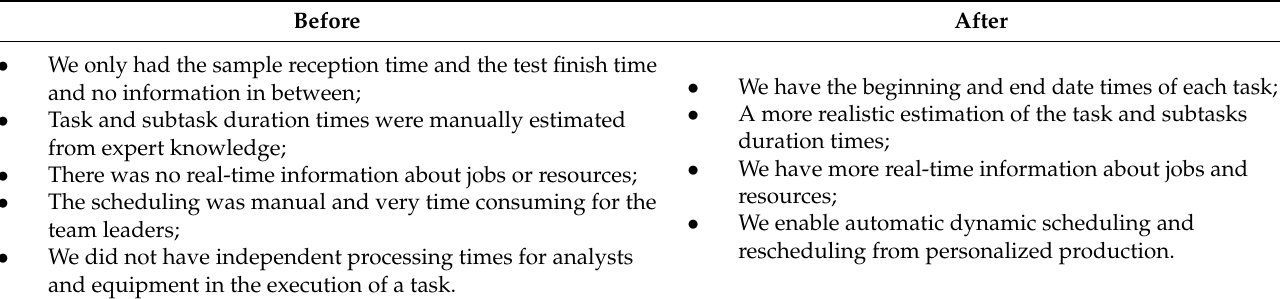
Table 1. Before and after the adoption of the proposed implementation.